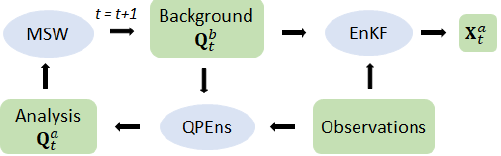
Figure 1. Schematic of the generation of the data sets Q b t , Q a t and X a t , where MSW stands for modified shallow water model.